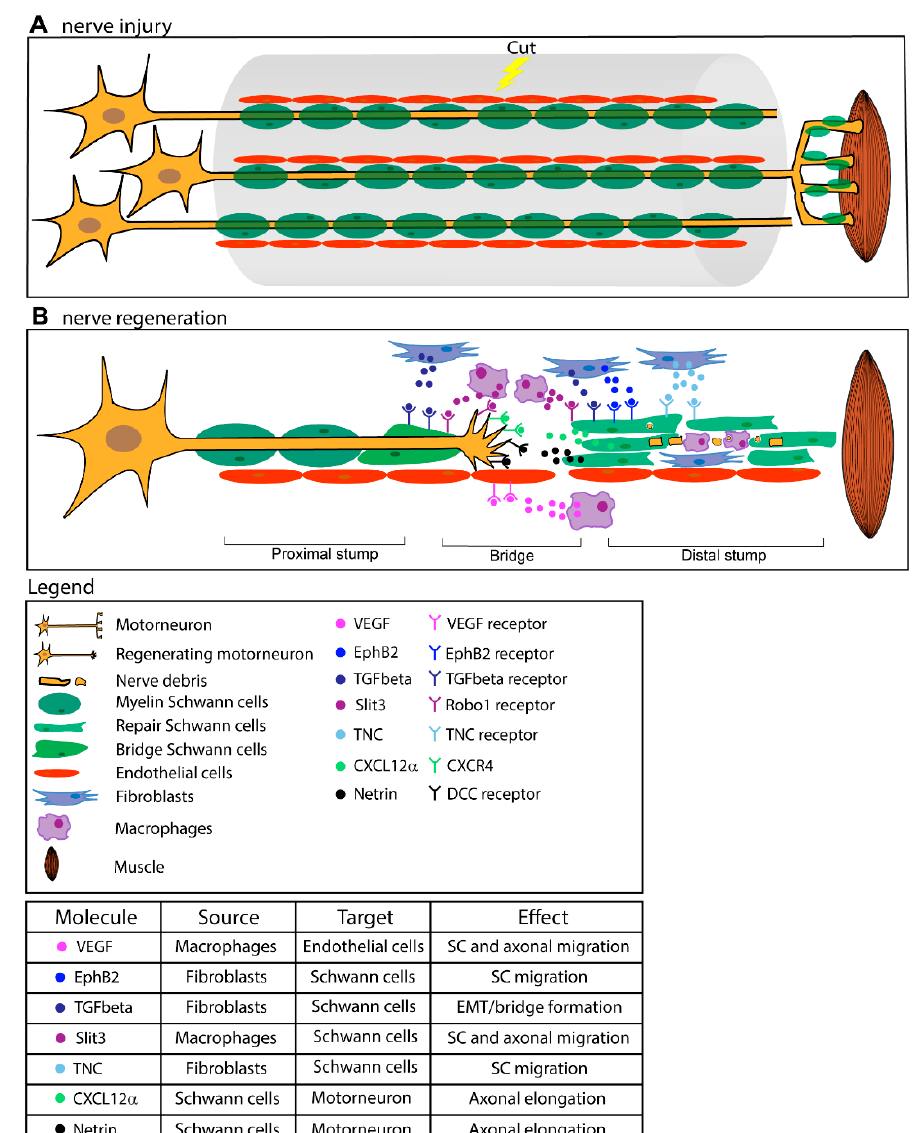
Figure 1. Schematic overview of the orchestrated response to a peripheral nerve injury. Nerve cut generates a gap between the two cut ends, and the distal one progressively degenerates. Repair Schwann cells (SC) (green) in the distal stump, activated by signals coming from the degenerating axon (yellow), are responsible for the clearance of nerve and myelin debris, the recruitment of macrophages (purple), and the secretion of neurotrophic factors. Within a few days, a bridge forms to reconnect the two stumps. Signals from endothelial cells (red), fibroblasts (blue), and macrophages guide collective and oriented SC migration through the bridge, allowing proper axonal re-growth.